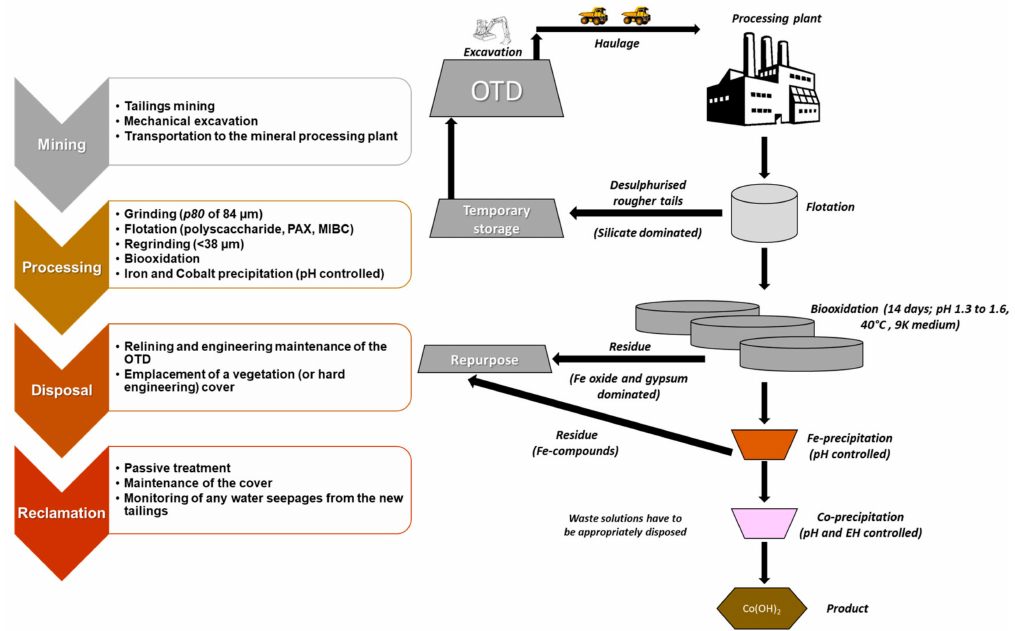
Figure 11. Diagram of potential tailings remining workflow. Here, new tailings are held in a temporary storage area before being returned to the OTD site following upgrade of the dam walls and lining. Residues from BIOX ® and Fe-precipitation should be considered for further valorization; e.g., use of Fe-oxides and/or gypsum as part of a tailings cover design or pigment recovery (see [62]); all waste waters from mineral processing will need to be appropriately